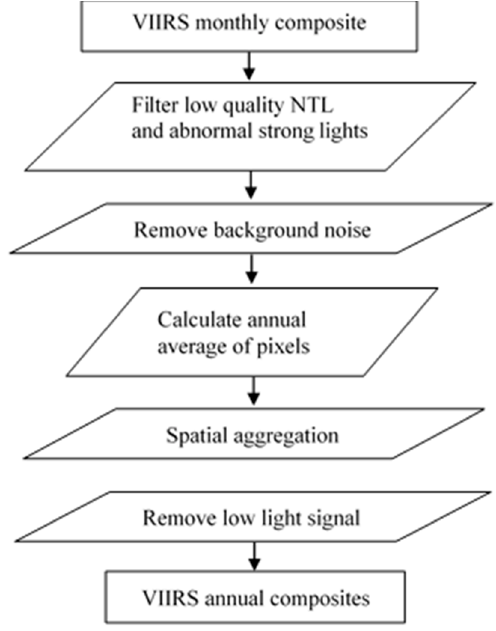
Figure 4. Making VIIRS annual composites.